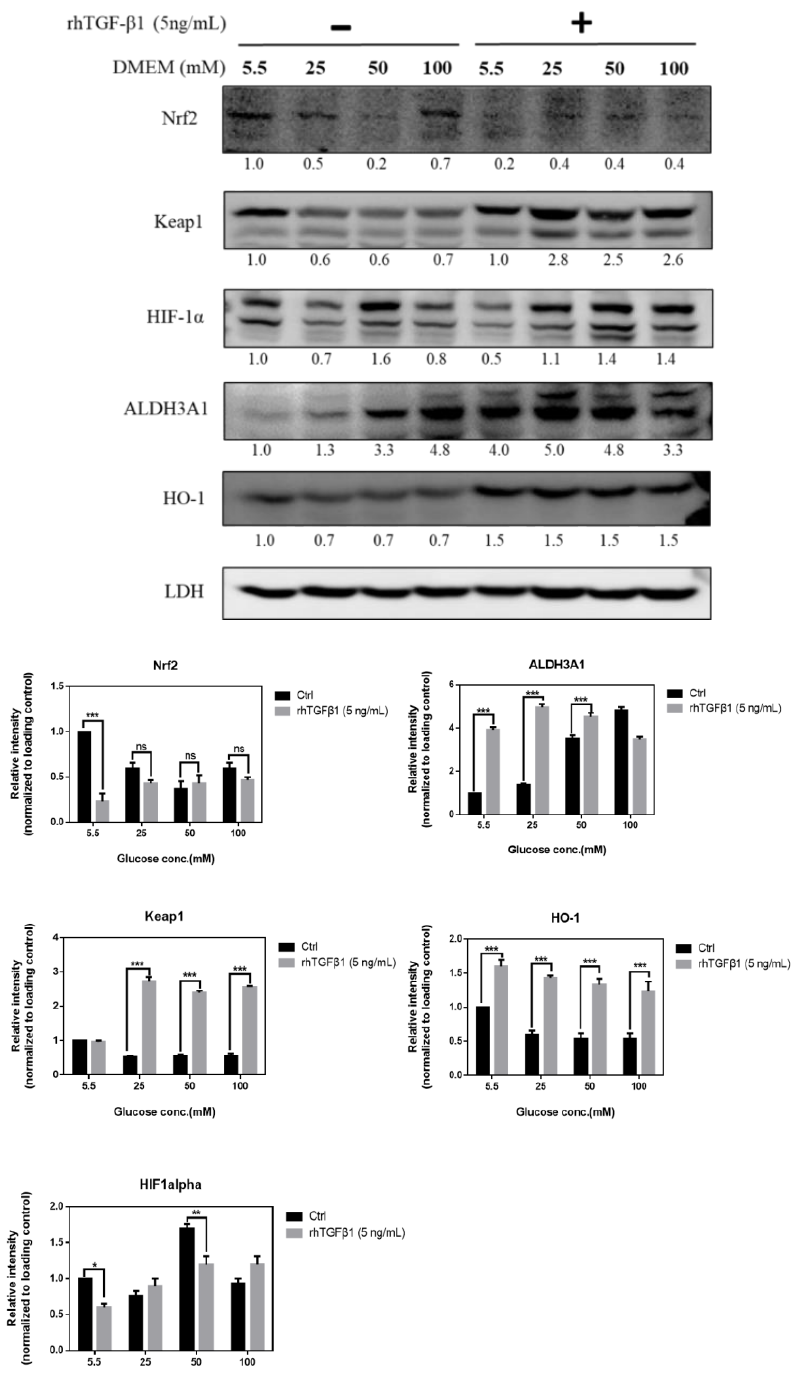
Figure 7. Immunoblot analysis in RGCs with hyperglycemia with or w / o recombinant TGF- β 1 protein (5 ng / mL). Immunoblot analysis of antioxidation pathway-associated proteins (Nrf2, Keap1, HIF-1 α , ALDH3A1, and HO-1) under 5.5 mM, 25 mM, 50 mM, and 100 mM glucose concentration medium with or w / o recombinant TGF- β 1 protein. The protein expression values were quantified in relation to the loading control. Data are represented as means ± SEM. *, p < 0.05; **, p < 0.01; ***, p < 0.001; ns, non-significant, when compared to the 5.5 mM group ( n = 3).